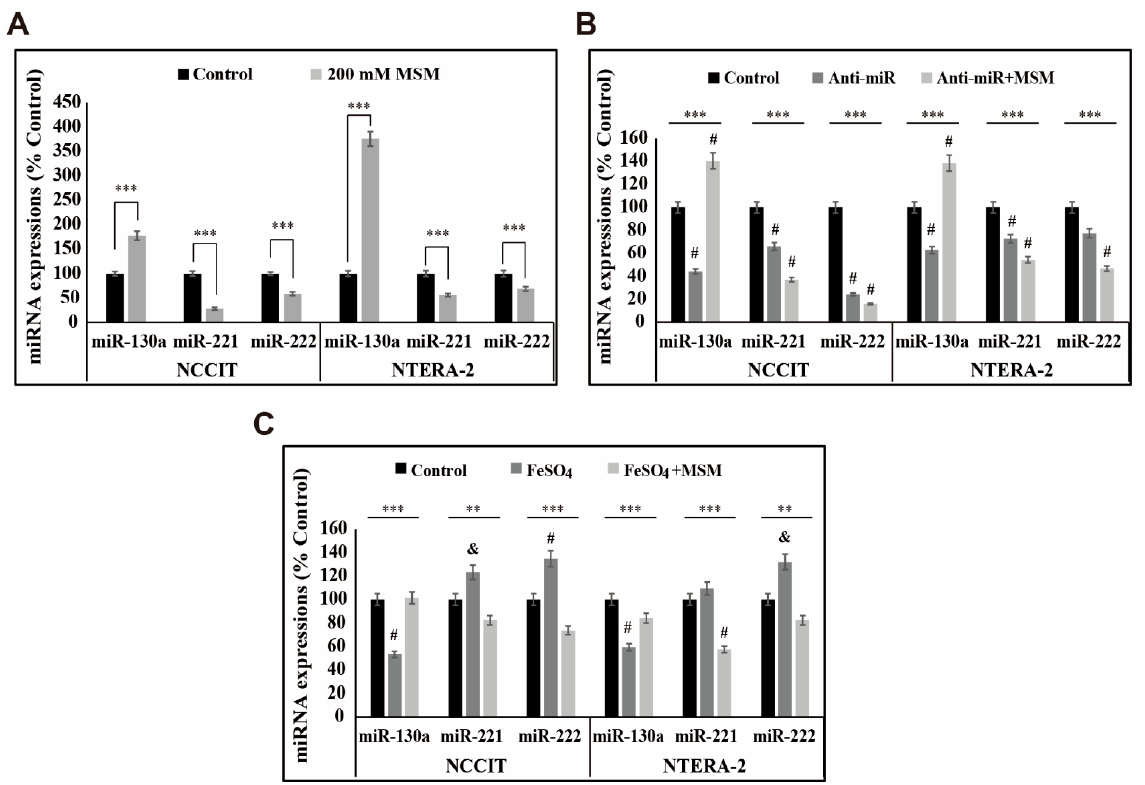
Figure 6. MSM regulated expressions of miR-130a, miR-221, and miR-222. ( A ) Real-time qPCR analysis of miR-130a, miR-221, and miR-222 expressions upon treatment with 200 mM MSM for 48 h in NCCIT and NTERA-2 cells. Representative expression of miR-130a, miR-221, and miR-222 mRNA were shown. Cp values were then normalized to U6 mRNA. Controls were set to 100. *** p < 0.001 (Student’s t -test). ( B ) Real-time qPCR of miR-130a, miR-221, and miR-222 expressions upon treatment with 60 pM anti-miR for 24 h, followed by 200 mM MSM for 48 h in NCCIT and NTERA-2 cells. The representative expression of miR-130a, miR-221, and miR-222 mRNA were shown; Cp values were then normalized to U6 mRNA. Controls were set to 100. *** p < 0.001 (ANOVA test). # p < 0.001 vs. control. ( C ) Real-time qPCR of miR-130a, miR-221, and miR-222 expressions upon treatment with 200 mM MSM for 48 h, followed by 200 µ M FeSO 4 for 48 h in NCCIT and NTERA-2 cells. The representative expressions of miR-130a, miR-221, and miR-222 mRNA are shown; Cp values were then normalized to U6 mRNA. Controls were set to 100. ** p < 0.01 and *** p < 0.001 (ANOVA test). & p < 0.01 vs. control. # p < 0.001 vs.